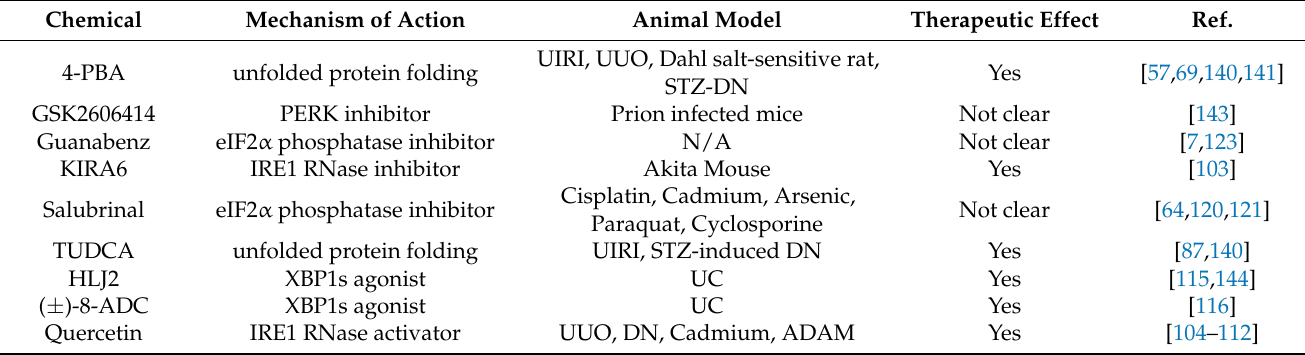
Table 1. Summarized the therapeutic effect of UPR